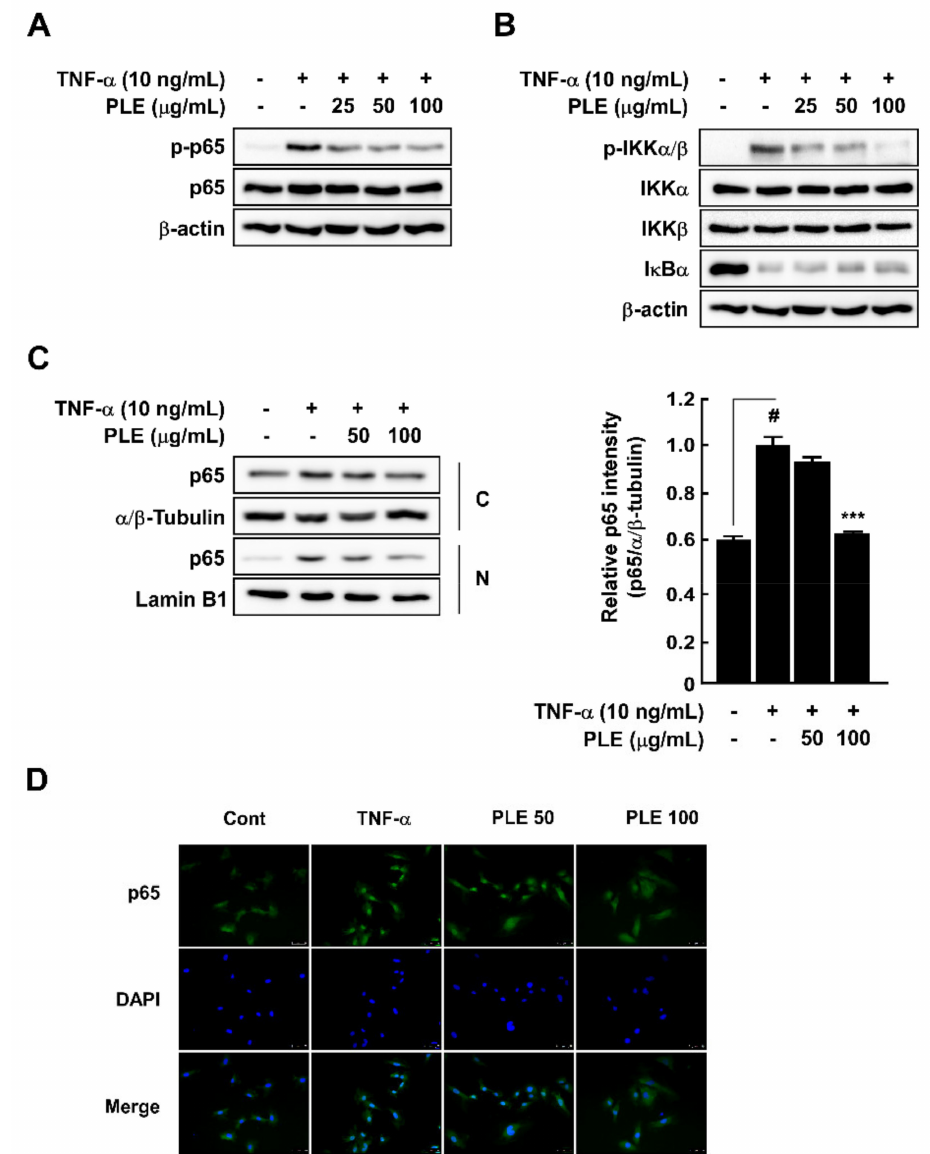
Figure 2. Paeonia lactiflora extract (PLE) rescued the TNF- α -induced NF- κ B signaling pathway and p65 translocation toward the nucleus in HUVECs. ( A ) p65 and p-p65 levels were measured using Western blotting. ( B ) Phosphorylated and total I κ B kinase (IKK) and I κ B degradation levels after PLE and TNF- α treatment measured using Western blotting. ( C ) p65 translocation from the cytosol to nuclear was measured after PLE and TNF- α treatments using Western blotting. α / β -tubulin was used as the cytosolic protein loading control, and Lamin B1 was used as the nucleic protein loading control. ( D ) p65 localization after treatment with PLE and TNF- α in HUVEC was measured using immunofluorescence. p65 is shown with green staining, and the nucleus is shown with blue staining. # p < 0.05, compared with the control group; *** p < 0.001, compared with the group exposed to TNF- α alone. Data are presented as the mean ± standard deviation of three independent